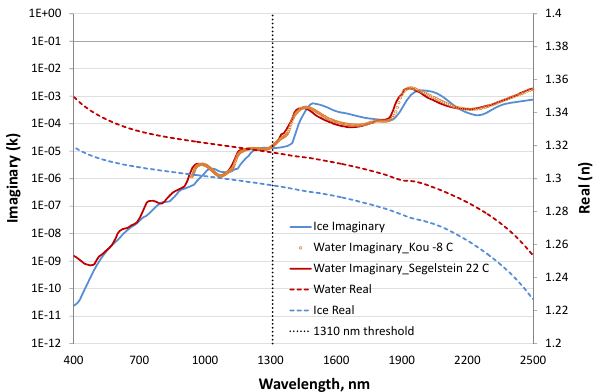
Figure 1. Real and imaginary indices of refraction of ice (from War- ren et al., 2008) and water (from Segelstein, 1981 and Kou et al.,